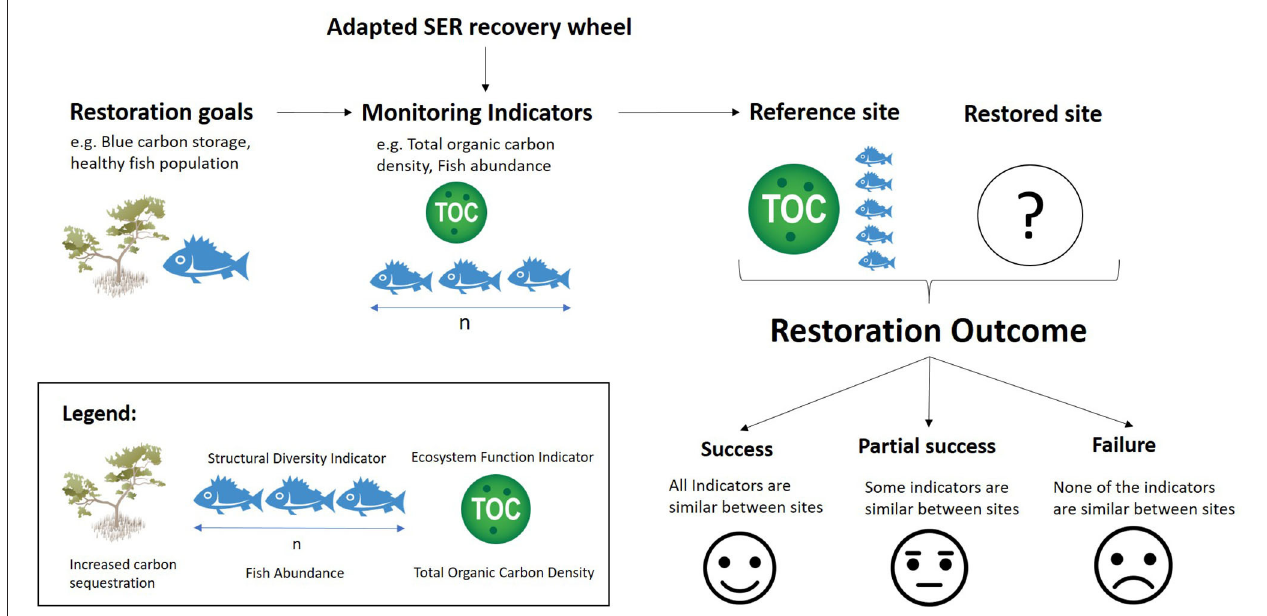
FIGURE 6 | Steps to assess restoration ecological outcome using structural and functional indicators.